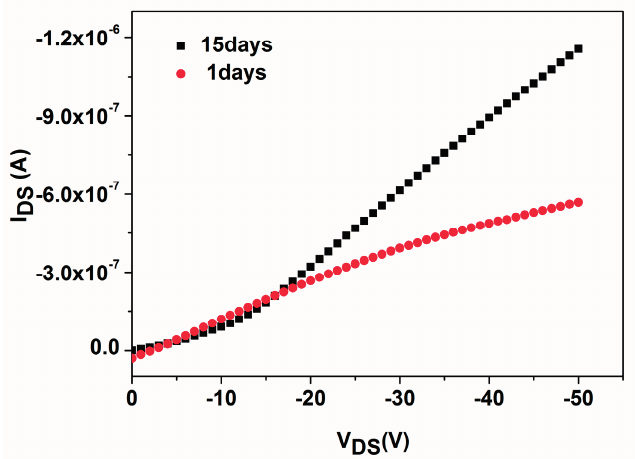
Figure 11. The typical output characteristic curves ( V GS = − 30V) of P3HT-ZnO hybrid thin film sensor stored after 1 and 15 days.